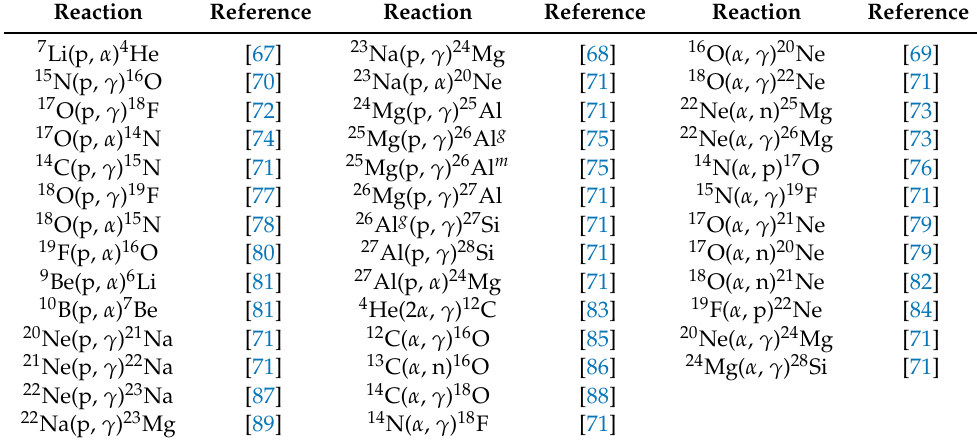
Table 1. Updated charged particle reactions included in the FUNS’s nuclear network.